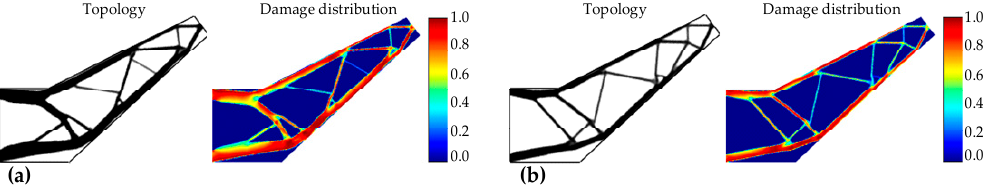
Figure 10. Optimal topology and damage distribution for an antenna bracket under a single load: ( a ) P-norm constraint ( f = 0.383), ( b ) local constraint ( f = 0.258).